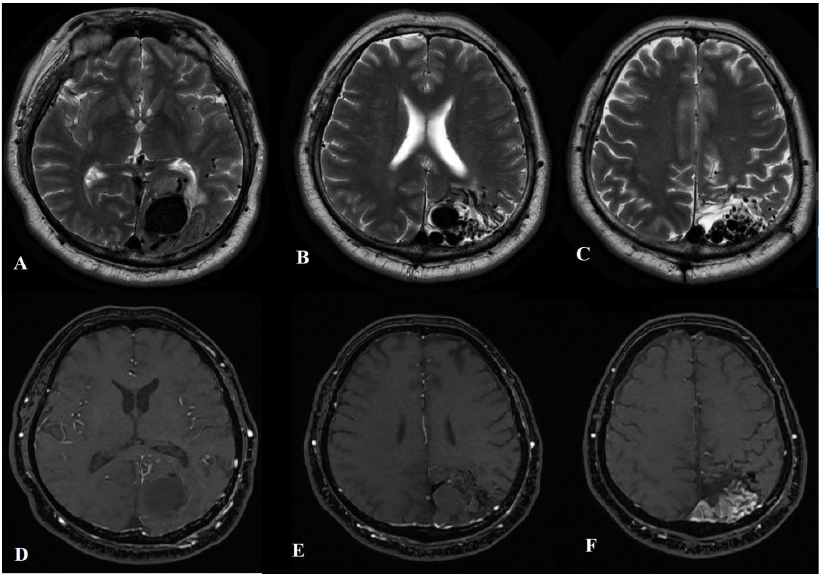
Figure 1. Axial T2-weighted ( A – C ) brain MRI and TOF MRA ( D – E ) demonstrating the left occipital AVM with an enlarged draining vein.